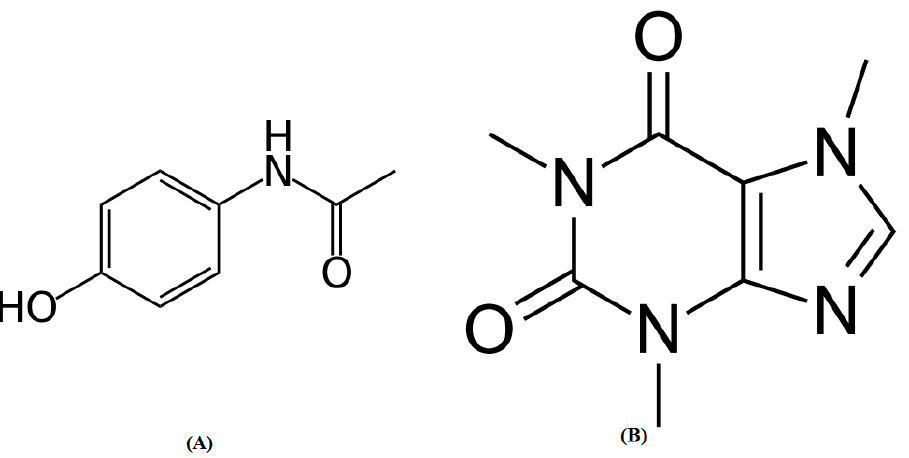
Figure 1. Chemical structures of ( A ) paracetamol and ( B ) caffeine.